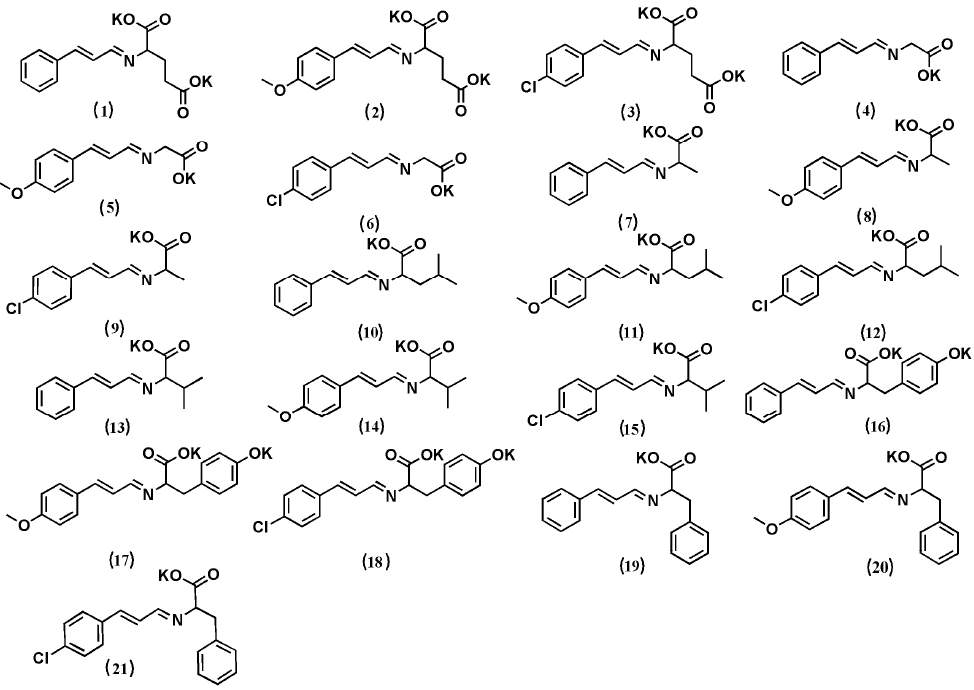
Figure 1. Structures of the 21 cinnamaldehyde-Schiff base compounds used to calculate the quantitative structure–activity relationship (QSAR).